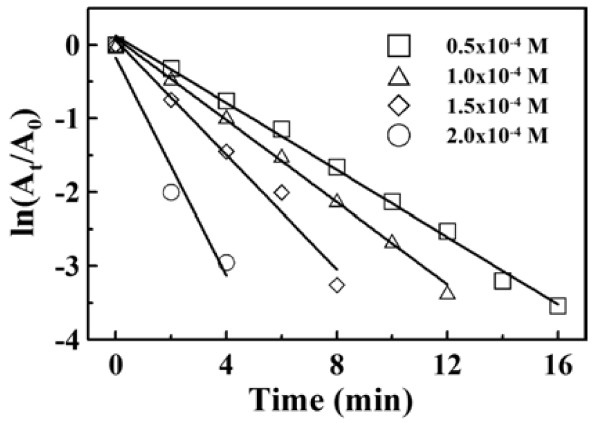
Plots of ln(At/A0) versus time for NaBH4-reduction of 4-NP at different initial concentrations of 4-NP. [Au]0 = 0.295 × 10−2 mg/mL, [NaBH4]/[4-NP] = 100, 30°C.